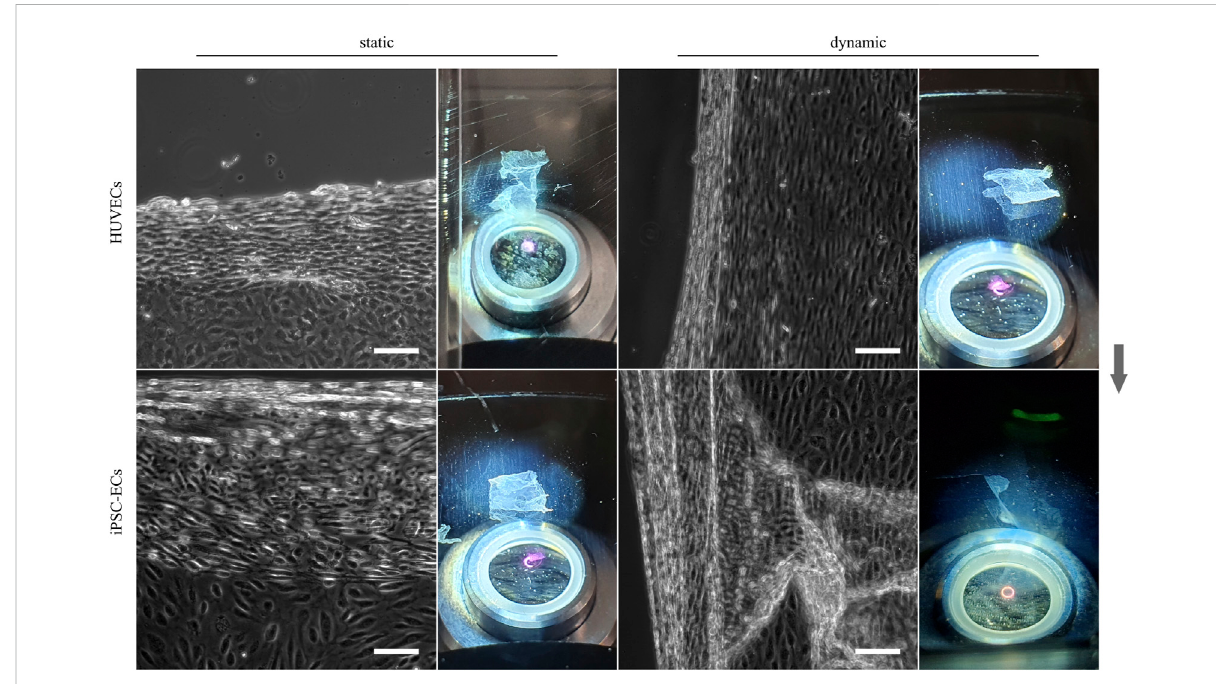
FIGURE 8 Enzyme-freeharvestofHUVECandiPSC-ECcellsheetsfromPGE-coatedPSsubstratestriggeredbyashorttemperatureswitchafterstaticand dynamic culture for 96 h. Detachment of cell sheets is shown for each condition by a representative phase contrast image as well as a photograph (Arrow indicates fl ow direction. Scale bars: 100 µm, n =